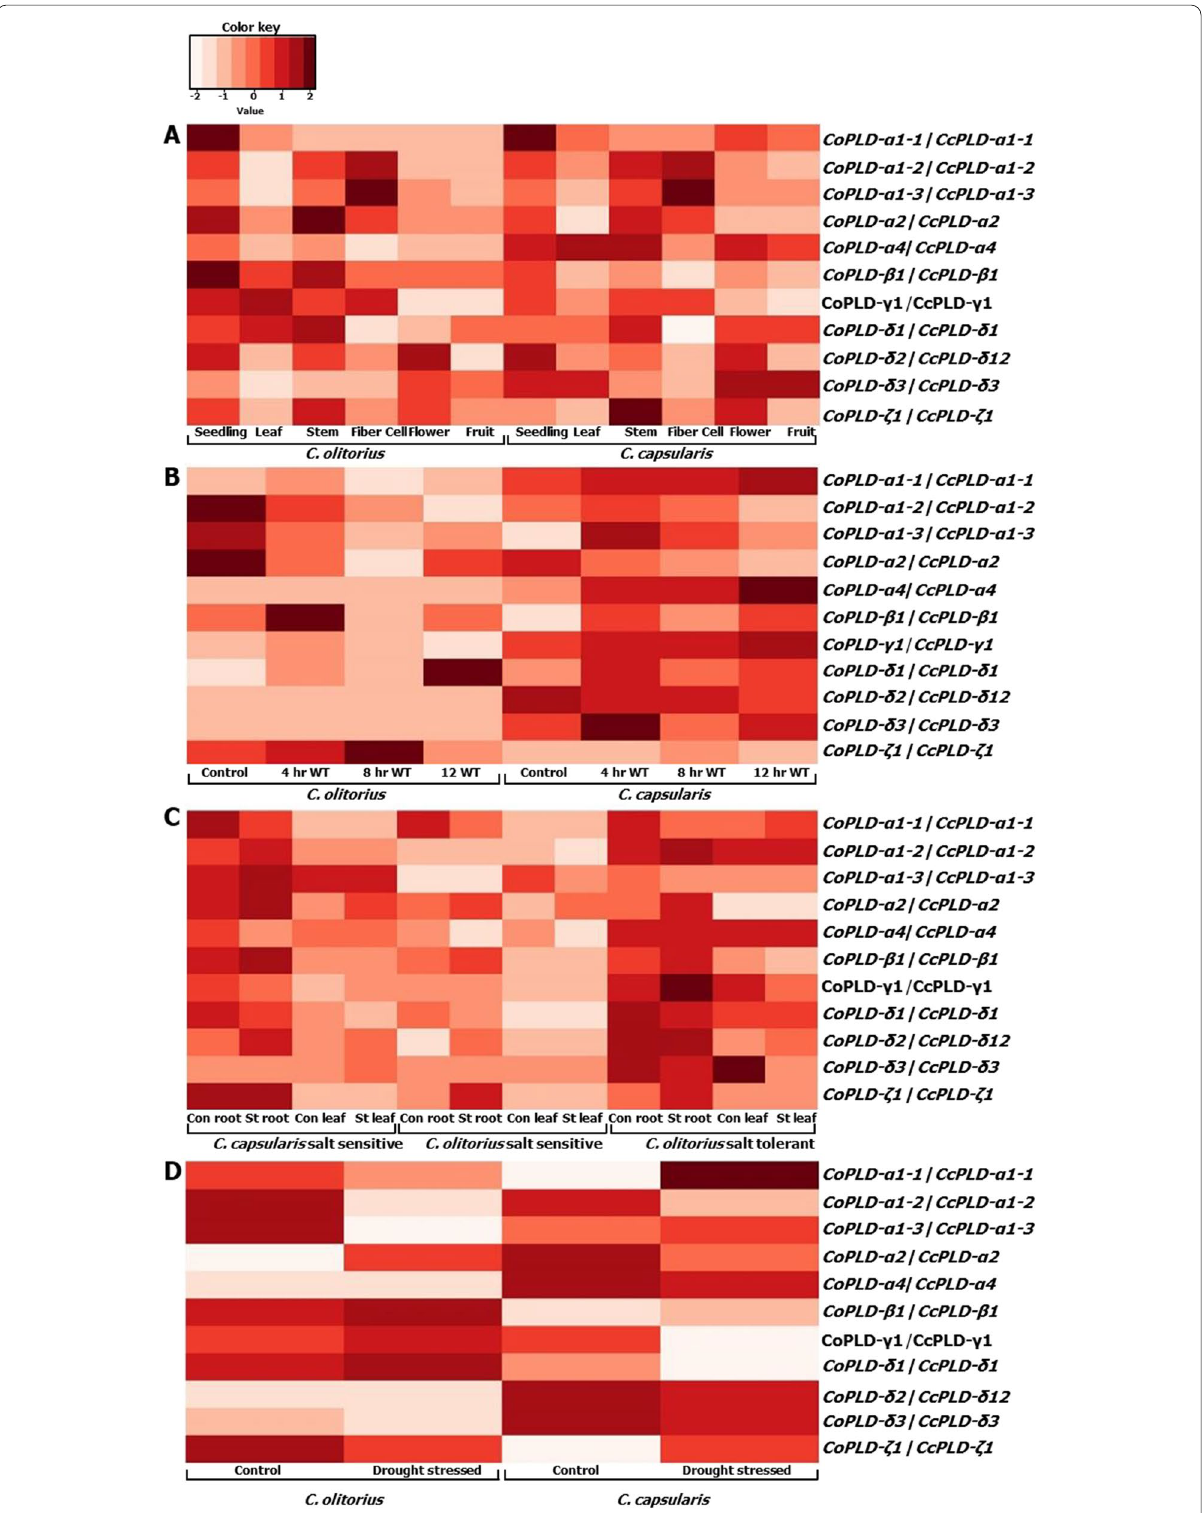
Fig. 5 Expression profiling of the member of PLD gene from two jute species ( C . capsularis and C . olitorius ). Tissue-specific gene expression of PLD proteins in various developmental tissues ( A ), in waterlogging stress condition ( B ), in salinity stress condition ( C ), and drought stress condition ( D ). Here, WT, con, and St indicates waterlogging, control, and stress,